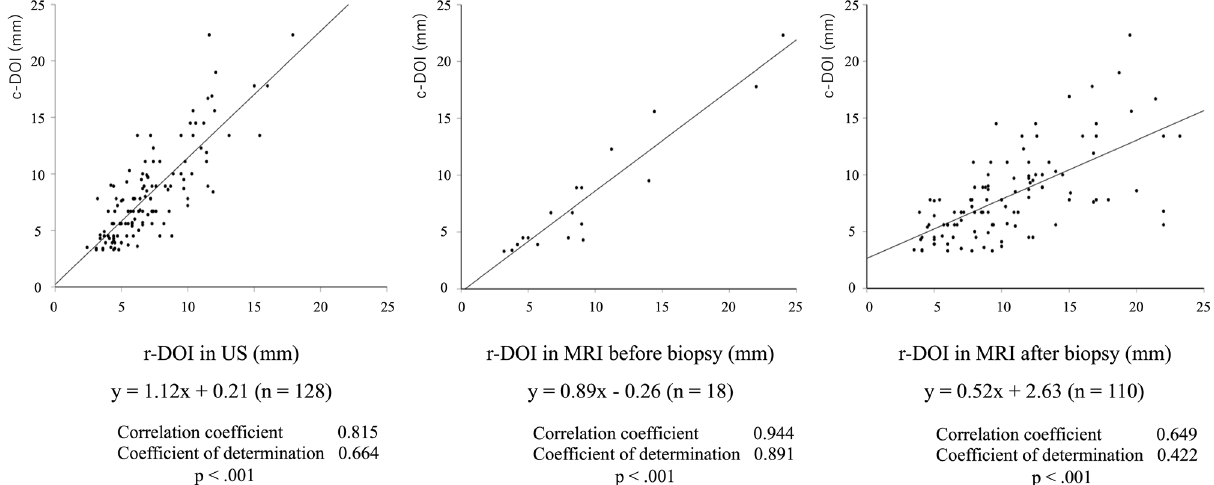
Figure 1. Relationship between c-DOI and each r-DOI. MRI before biopsy was the most concordant with c-DOI. r-DOI using MRI after biopsy overestimated DOI because of inflammatory reaction of the tongue muscles caused by biopsy. c-DOI clinical depth of invasion, r-DOI radiological depth of